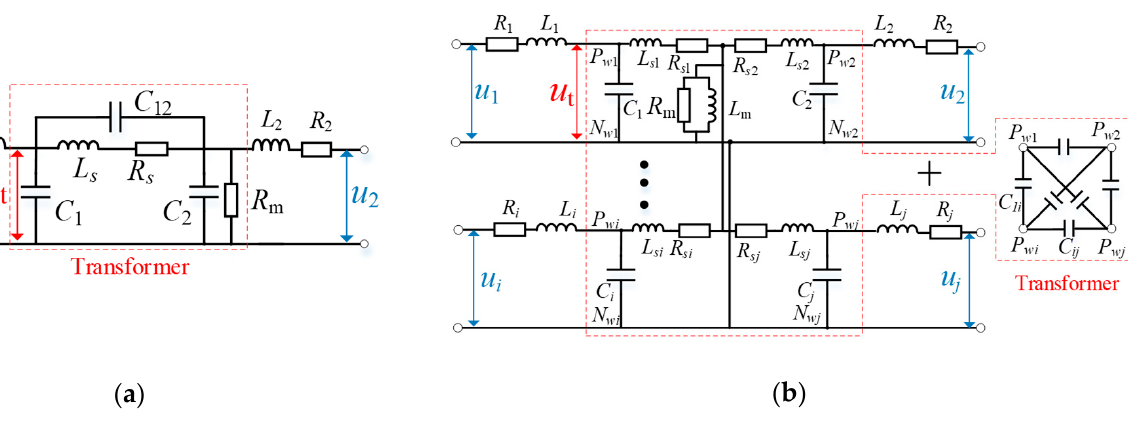
Figure 2. Equivalent HF circuit considering the stray parameters of the transformer. ( a ) DAB con ‐ verter; ( b ) MAB converter.